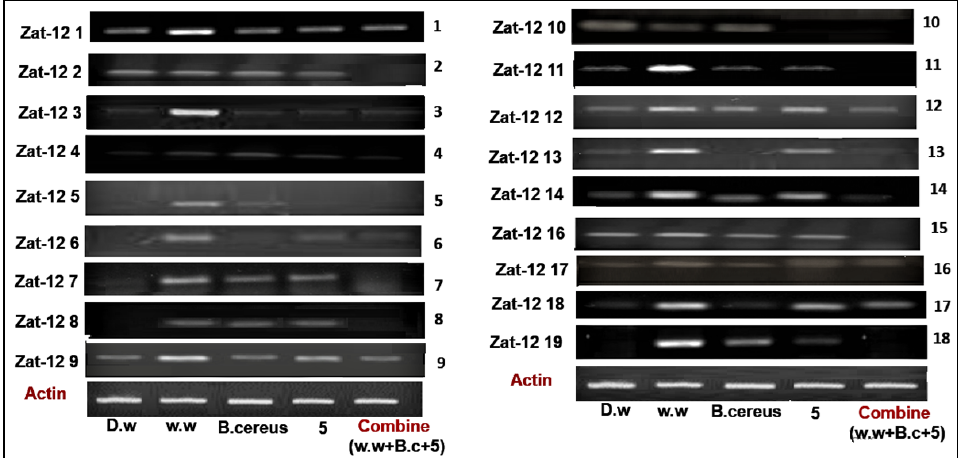
Figure 7. The expression profile of the zinc finger protein (Zat-12) gene family of rice plants that were grown by the synergistic treatment of bacteria-primed seeds that were grown in 5 mg/L ZnO NPs and HMs-contaminated water. The treatments are: DW (distilled water), w.w (wastewater), Bio-priming ( Bacillus cereus + w.w), ZnO NPs treatment (5 mg/L + w.w), and combined treatments ( Bacillus cereus + 5 mg/L ZnO NPs + w.w).